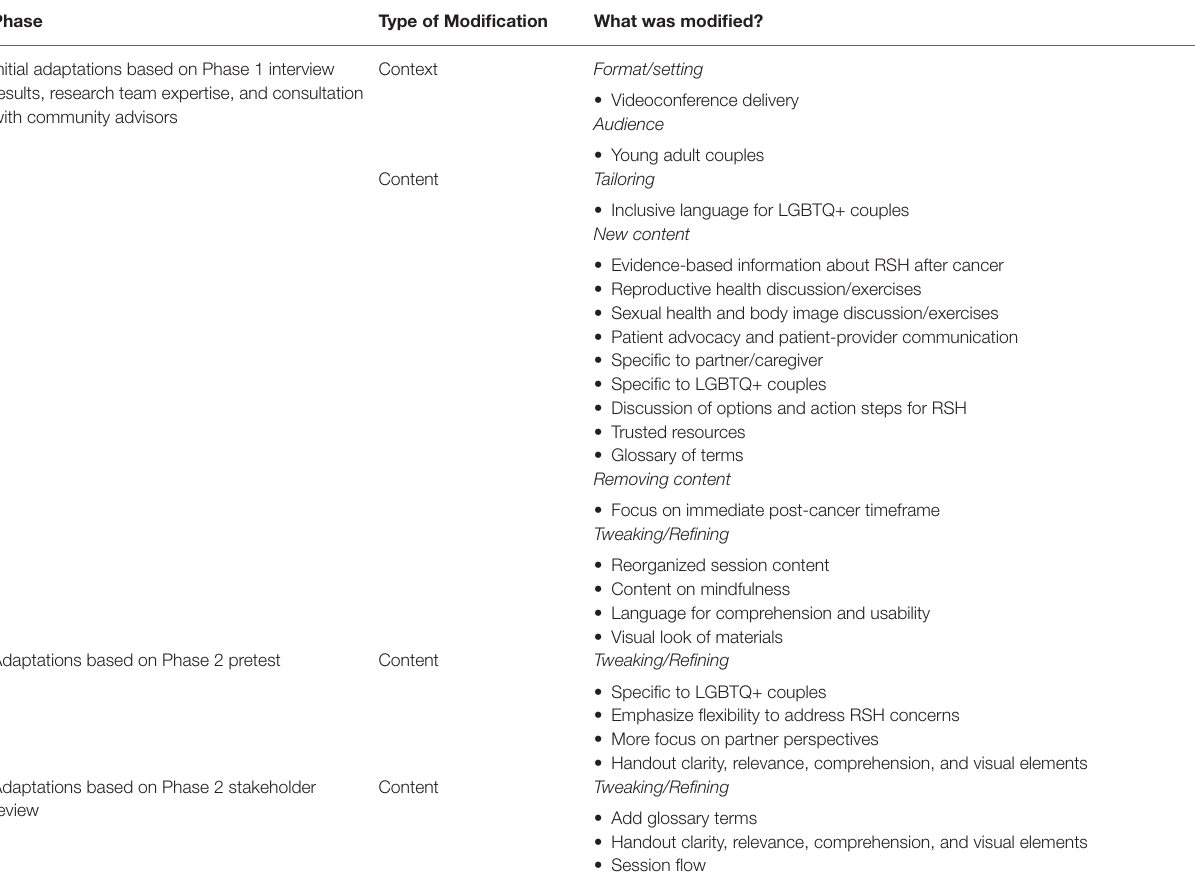
TABLE 3 | Summary of major intervention adaptions across